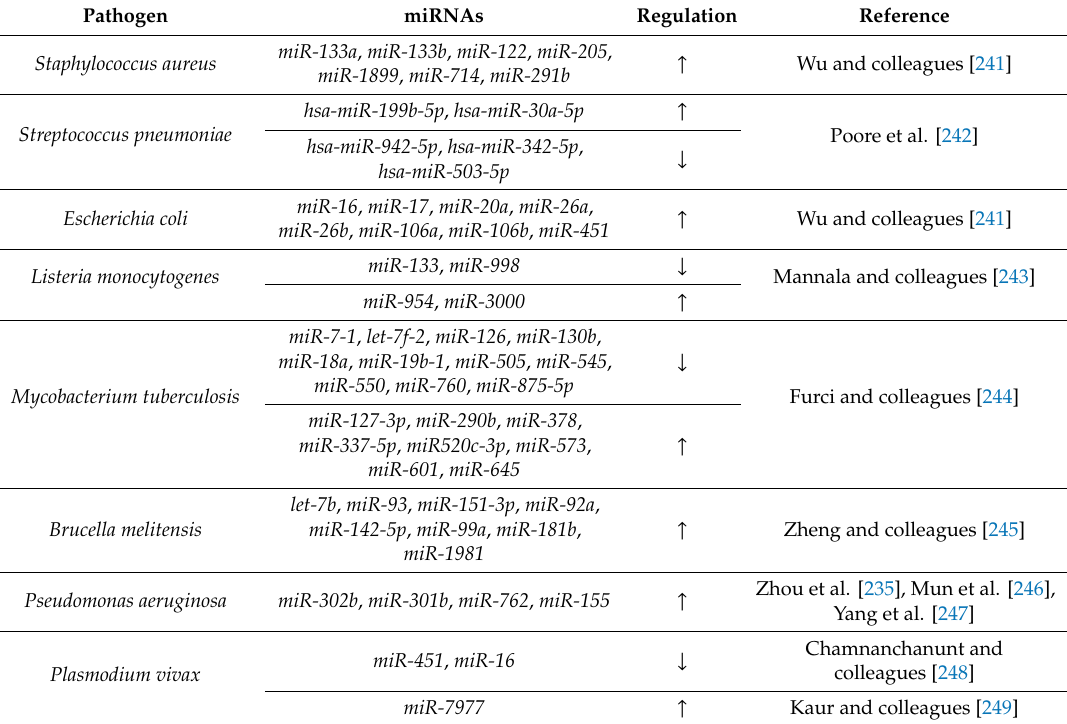
Table 3. miRNA regulation in bacterial